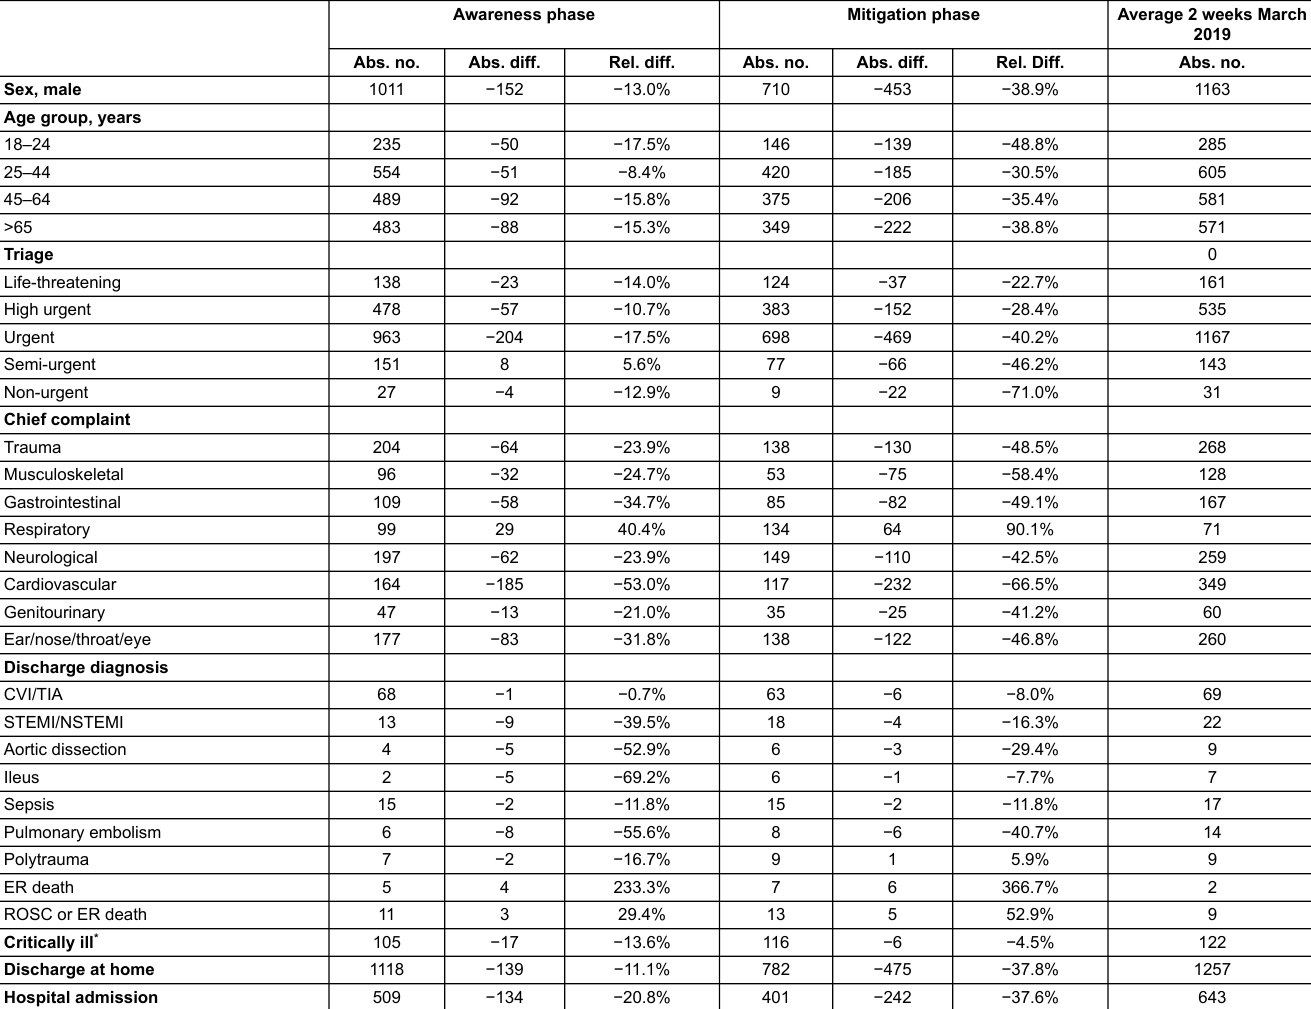
Table S1: Absolute numbers of characteristics in the three studied phases and relative differences of the awareness respectively mitigation phases and the control